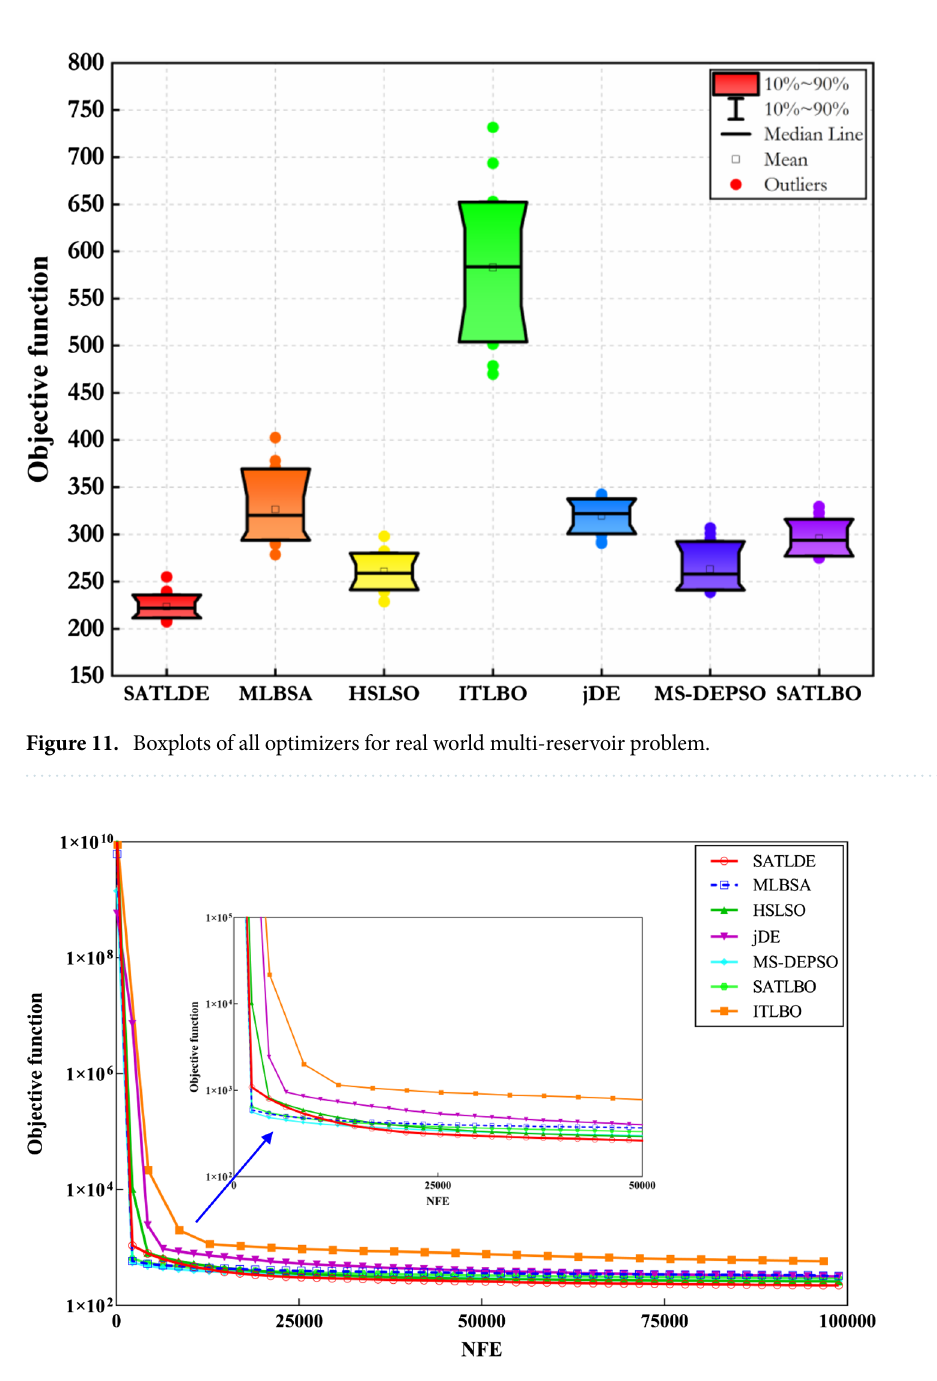
Box plot analysis. Box plot graph is used to illustrate the variation rate of the fitness function calculated by the proposed SATLDE and other optimization methods during 30 different runs. Figure 11 depicts the Box plot of 7 optimizers for the multi-reservoir system. The figure indicates the seven optimization algorithms’ maxi- mum, minimum, and average fitness functions. In addition, the Box plot shows the density range of fitness func- tion over 30 runs. It can be seen that compared with six other optimization algorithms, the location of SATLDE is clearly lower, and the range of distribution is smaller, indicating the priority of the optimization technique. Therefore, SATLDE can be utilized as an efficient tool for optimizing multi-reservoir problems. Convergence trajectory analysis. Figure 12 illustrates the convergence graphs of seven methods for the multi-reservoir problem. The figure displays the average values of the fitness function for all optimizers, obtained in 30 different runs. It has been discovered that the SATLDE has a faster convergence speed than the other